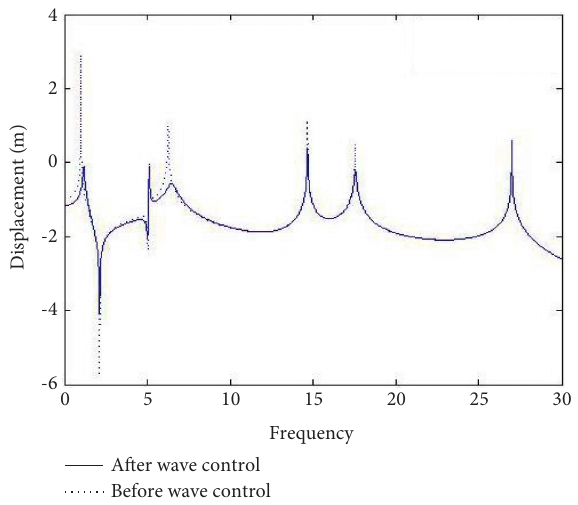
Figure 7: Frequency response before and after wave